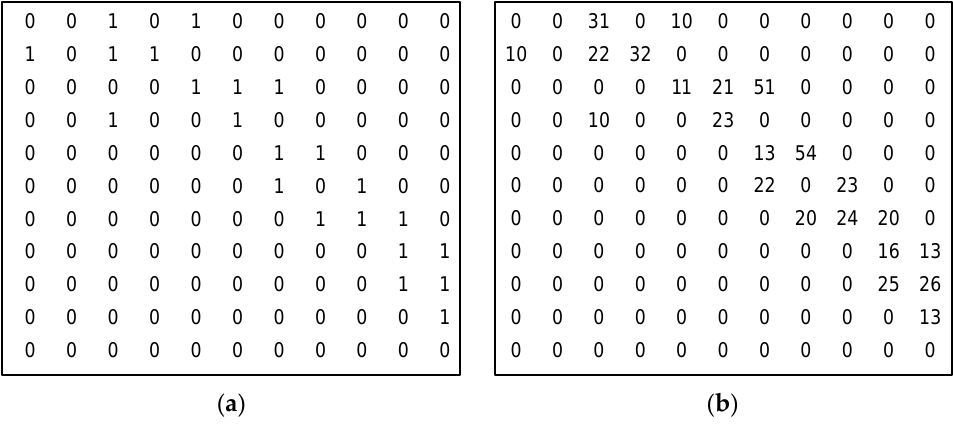
Figure 3. The matrices corresponding to the graph presented in Figure 2: ( a ) edge matrix 𝑊 ′ showing the edges of the graph and ( b ) edge weight matrix 𝑊 showing the edge weights.